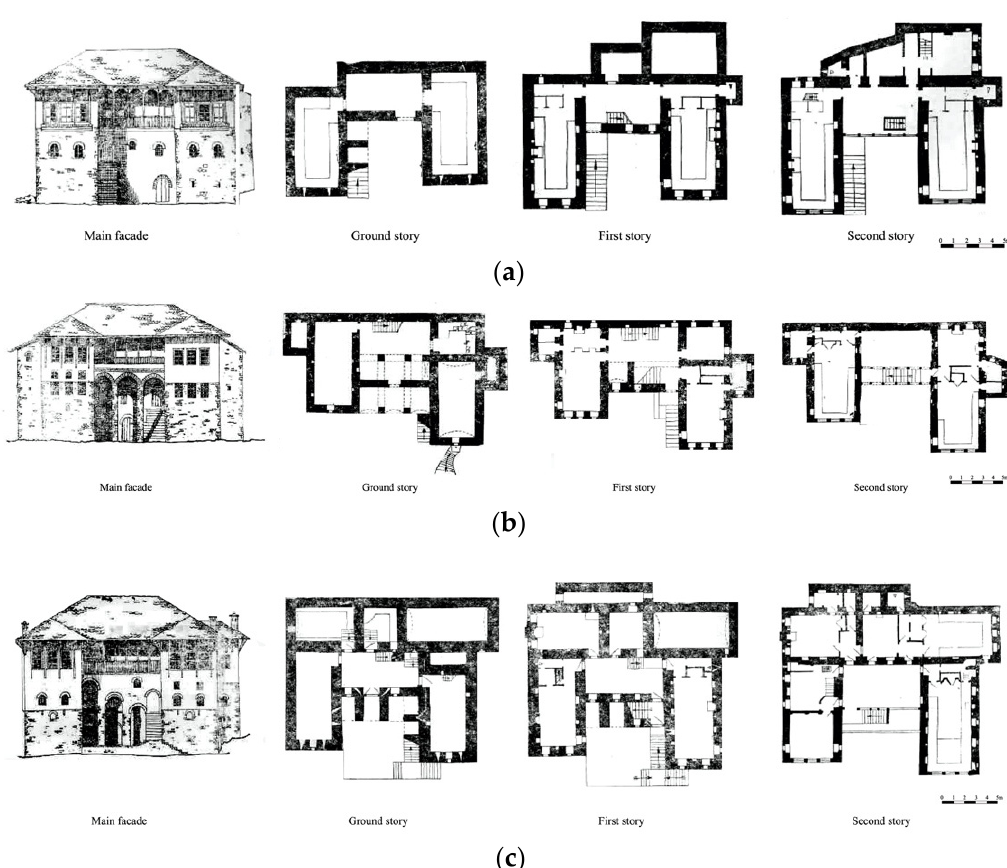
Figure 6. Examples of the double-wing building: ( a ) Babameto Building (1885), ( b ) Zekate Building (1812), ( c ) Skëndulaj Building (1823) (adapted from [3]).